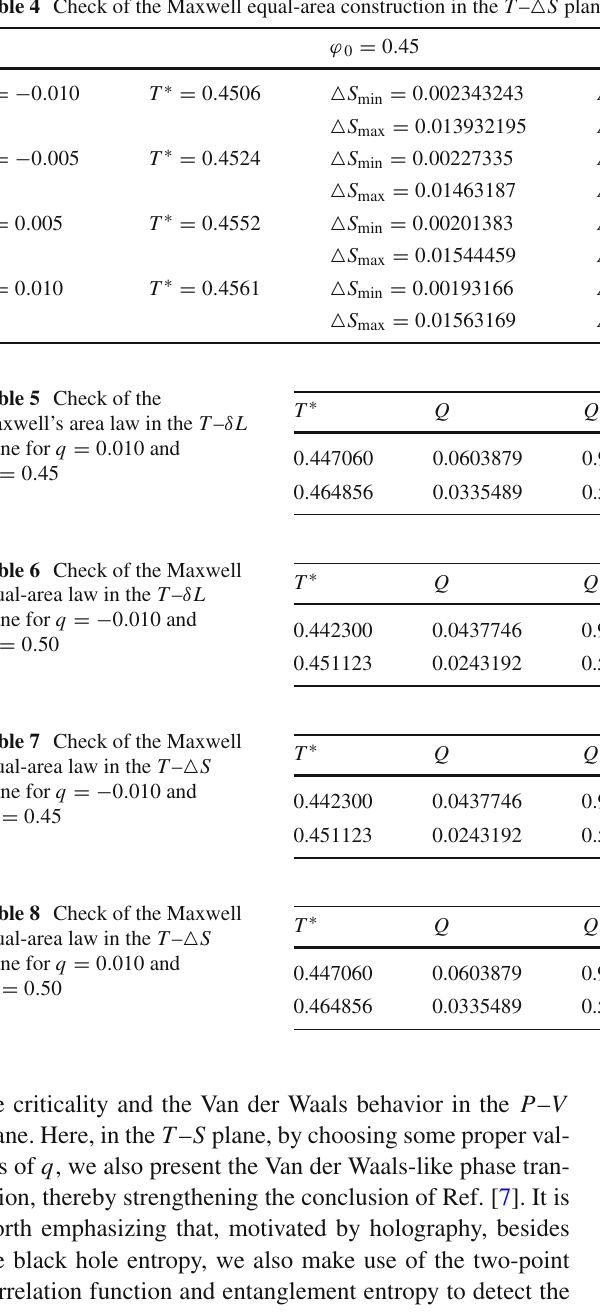
Table 4 Check of the Maxwell equal-area construction in the T – (cid:8) S plane